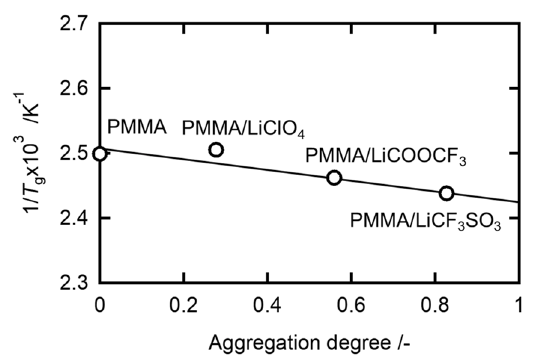
Figure 3. The inverse dependence of T g on the aggregation degree for the PMMA/salt samples with [Li]/[C=O] = 0.07.